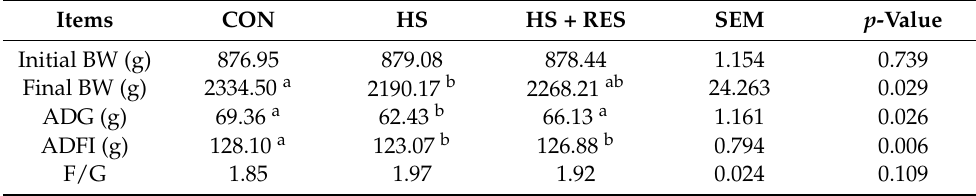
Table 1. Effects of RES on the growth performance of heat-stressed broilers.